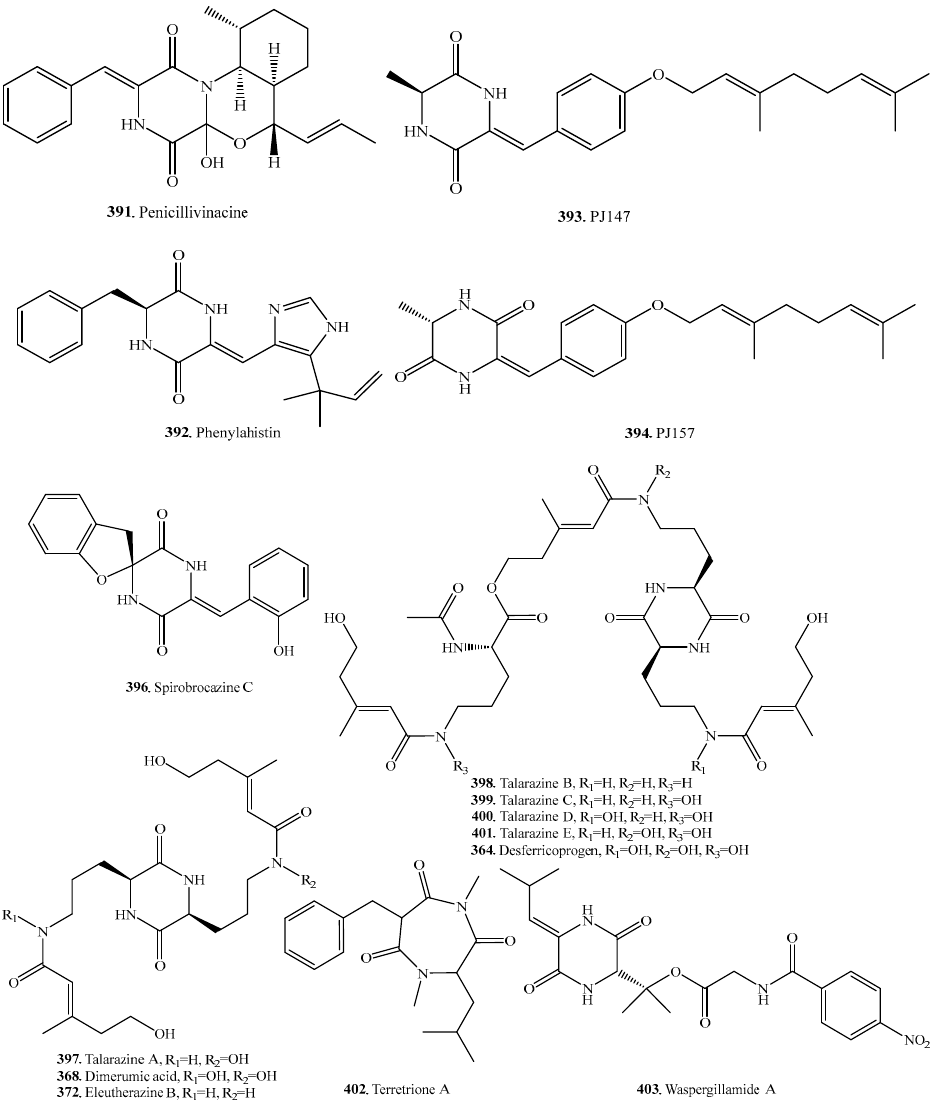
Figure 5. Structures of the non-tryptophan-non-proline cyclodipeptide analogs isolated from